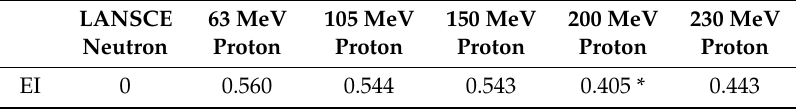
Table 2. EI for secondary particle yields in layer structure without SiGe. LANSCE 63 MeV 105 MeV 150 MeV 200 MeV 230 MeV Neutron Proton Proton Proton Proton Proton EI 0 0.560 0.544 0.543 0.405 * 0.443